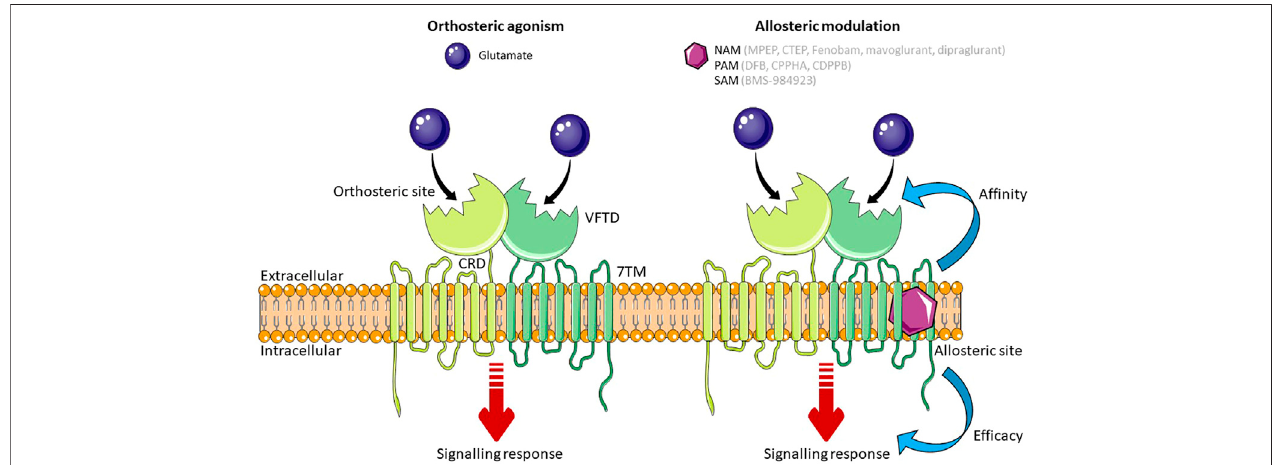
FIGURE 1 | Schematic of mGlu 5 activation. Glutamate, the endogenous ligand for mGlu 5 , binds at the orthosteric site in the VFTD. Allosteric modulators (NAMs, PAMsand SAMs) bind toa topographically distinct site in the7TM domain. Simultaneous binding ofan orthosteric agonist and anallostericmodulatoreffectsthe af fi nity or ef fi cacy of the orthosteric agonist. Some allosteric modulators are able to exert their effect independent to the orthosteric agonist. Abbreviations: NAM, Negative Allosteric Modulator; PAM, Positive Allosteric Modulator; SAM, Silent Allosteric Modulator; VFTD, Venus Flytrap Domain; 7TM, 7 transmembrane domain; CRD, Cysteine Rich Domain. Figure created using Reactome Icon Library, licensed under CC BY 4.0 (Sidiropoulos et al., 2017).